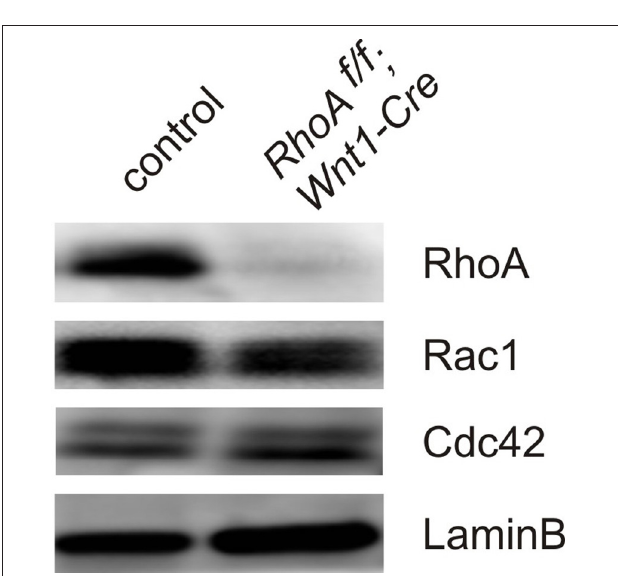
FIGURE 2 | Expression of RhoA, Rac1, and Cdc42 in DRGs from E12.5 control and RhoA f / f ; Wnt1-Cre embryos. RhoA, Rac, and Cdc42 proteins were evaluated by Western blotting using DRGs from E12.5 control and RhoA f / f ; Wnt1-Cre embryos. RhoA protein was significantly reduced in DRGs from RhoA f / f ; Wnt1-Cre embryos compared to control DRGs. RhoA deletion did not affect protein expression of Rac1 and Cdc42. We examined expression of LaminB protein as an internal